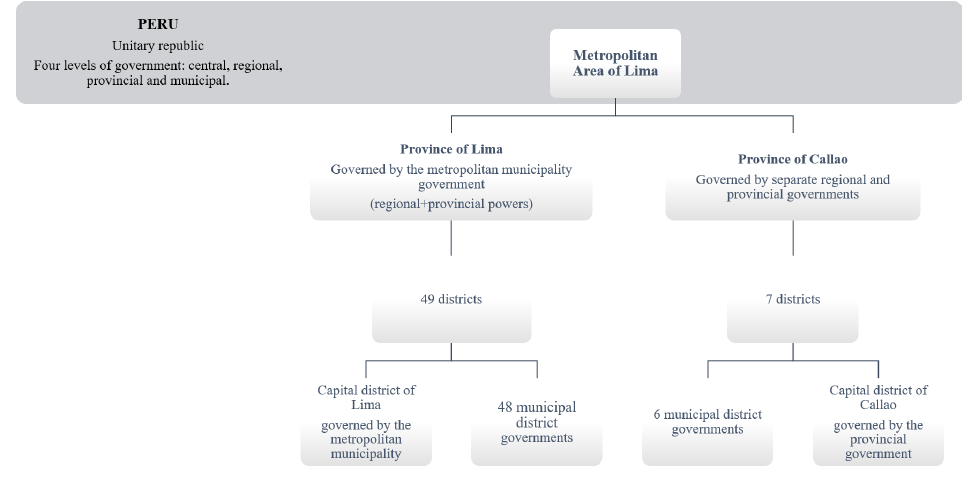
Figure 5: Government structure, Metropolitan Area of